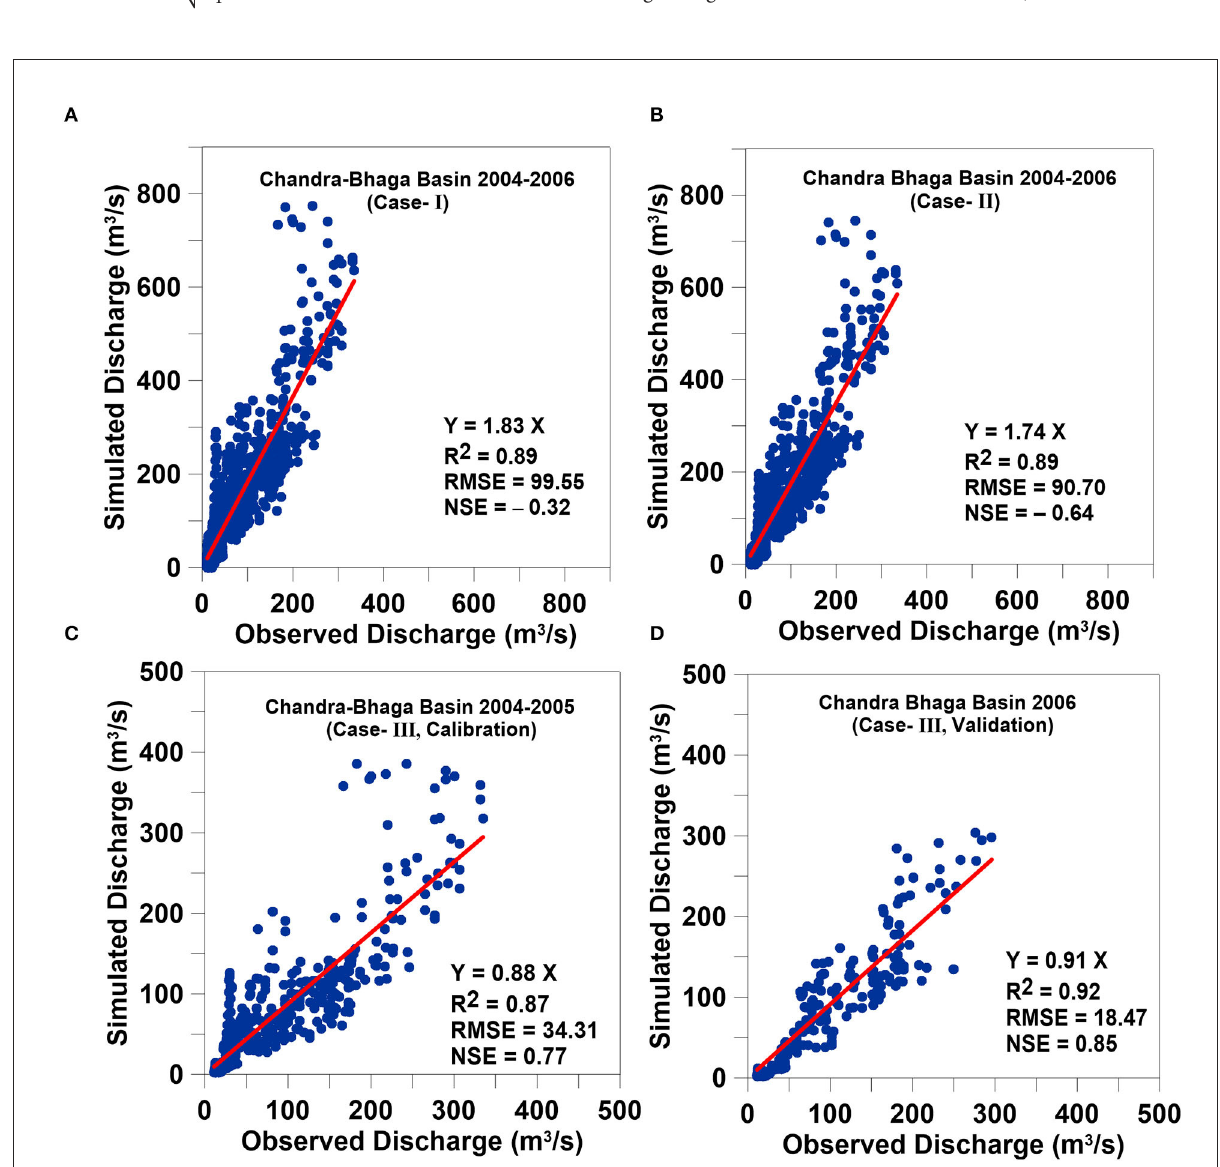
FIGURE6 Scatter plots between the observed and simulated discharge for Chandra-Bhaga Basin in all three case scenarios (A) Chandra-Bhaga Basin 2004–2006 (Case-I), (B) Chandra-Bhaga Basin 2004–2006 (Case-II), (C) Chandra-Bhaga Basin 2004–2005 (Case-III, calibration), and (D) Chandra-Bhaga Basin 2006 (Case-III,